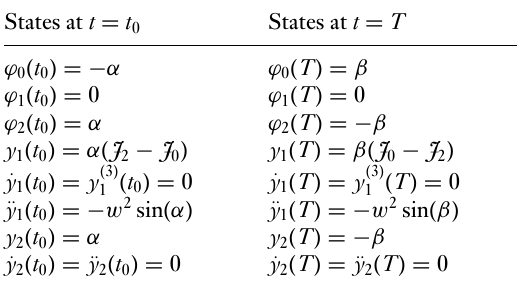
Table 2 Relationships between flat outputs States at t = t 0